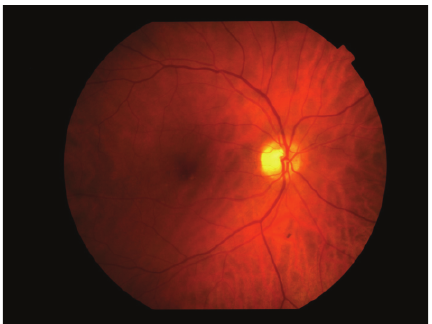
Figure 1: Color fundus photography of right eye with rare macular hard drusen and scattered peripheral retinal pigment.